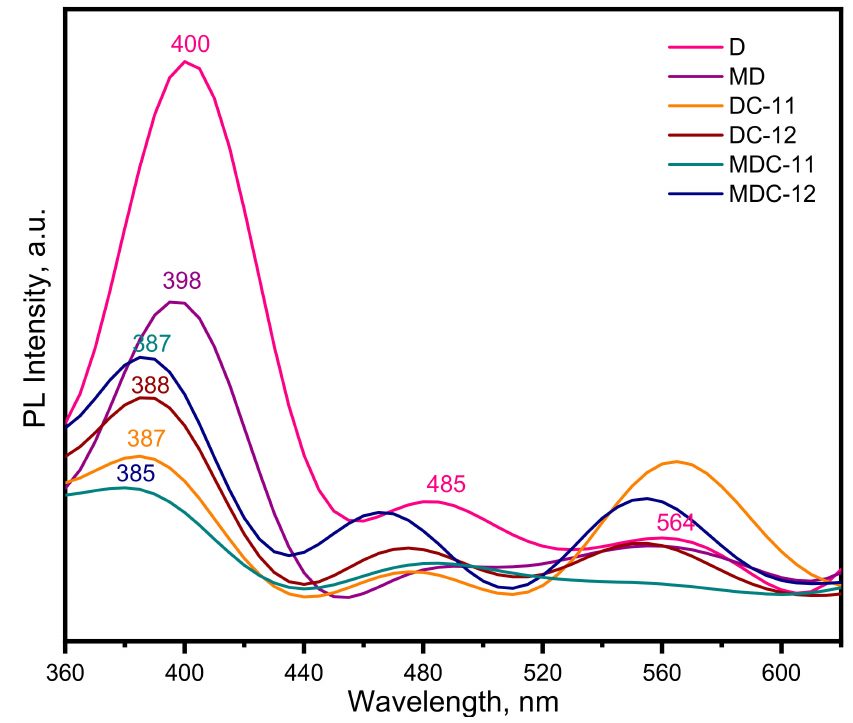
Figure 6. PL spectra of D, MD, DC-11, DC-12, MDC-11, and